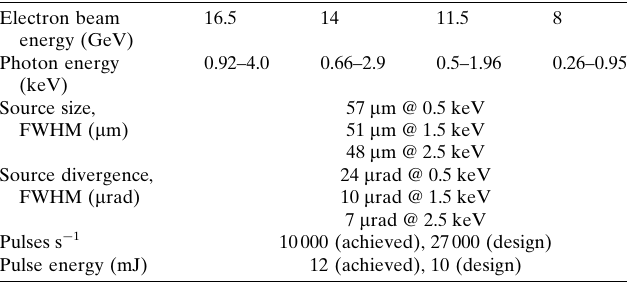
Table 1 FEL beam parameters.